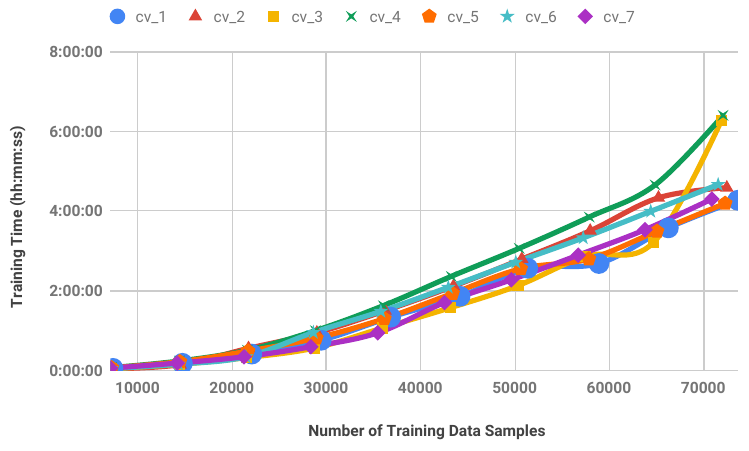
Figure 6. Model training times for stratified random selection procedure. A seven-fold cross-validation experiment is performed on CB513